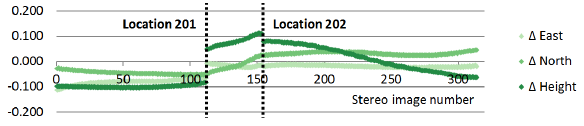
Figure 9. Deviations of projection centers in m for sequence 2.0